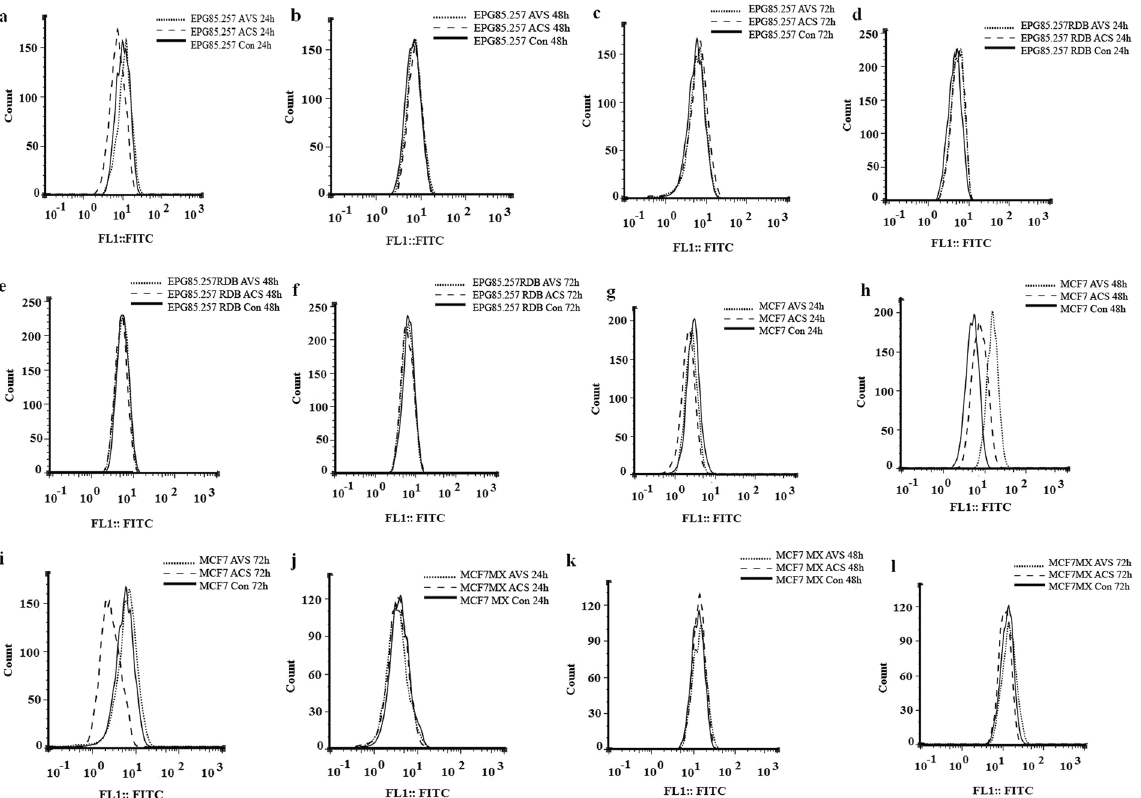
Figure 1. Relative quantification of MDR proteins using flow cytometer. MDR1 and BCRP protein levels of EPG85.257 and MCF7 parental and their resistant counterparts were quantified in the presence of acetylshikonin and acetoxyisovalerylshikonin. ACS, acetylshikonin; AVS, acetoxyisovalerylshikonin; Con,